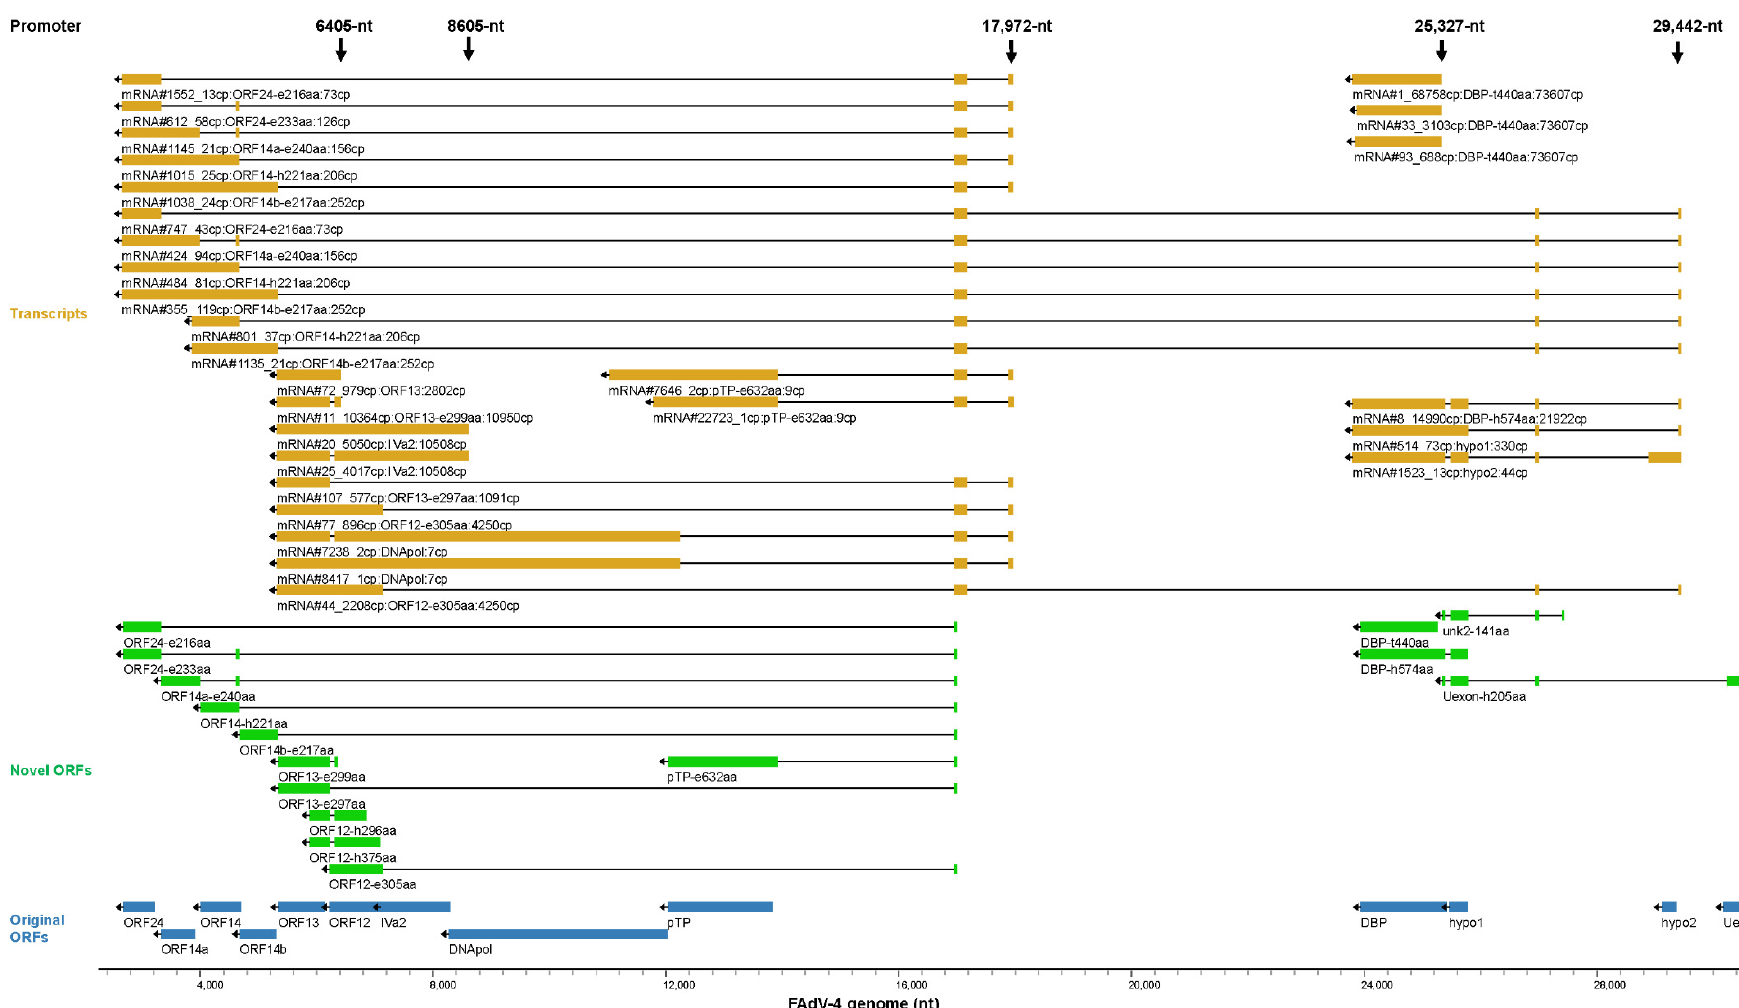
Figure 8. Key transcripts controlled by the reverse 6405-nt, 8605-nt, 17,972-nt, 25,327-nt and 29,442-nt promoters. The related annotation and explanation can be found in the legend of Figure 5.